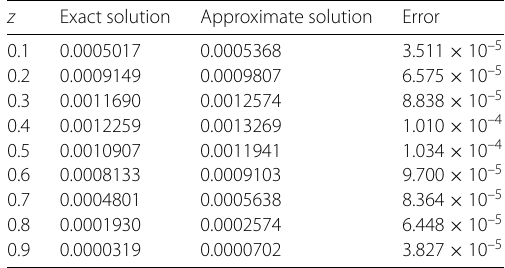
Table 8 Absolute errors for Example 2 at t = 0.1 with (cid:3) t = 0.001, α = 0.5, N = 10, and z ∈ [0,1]